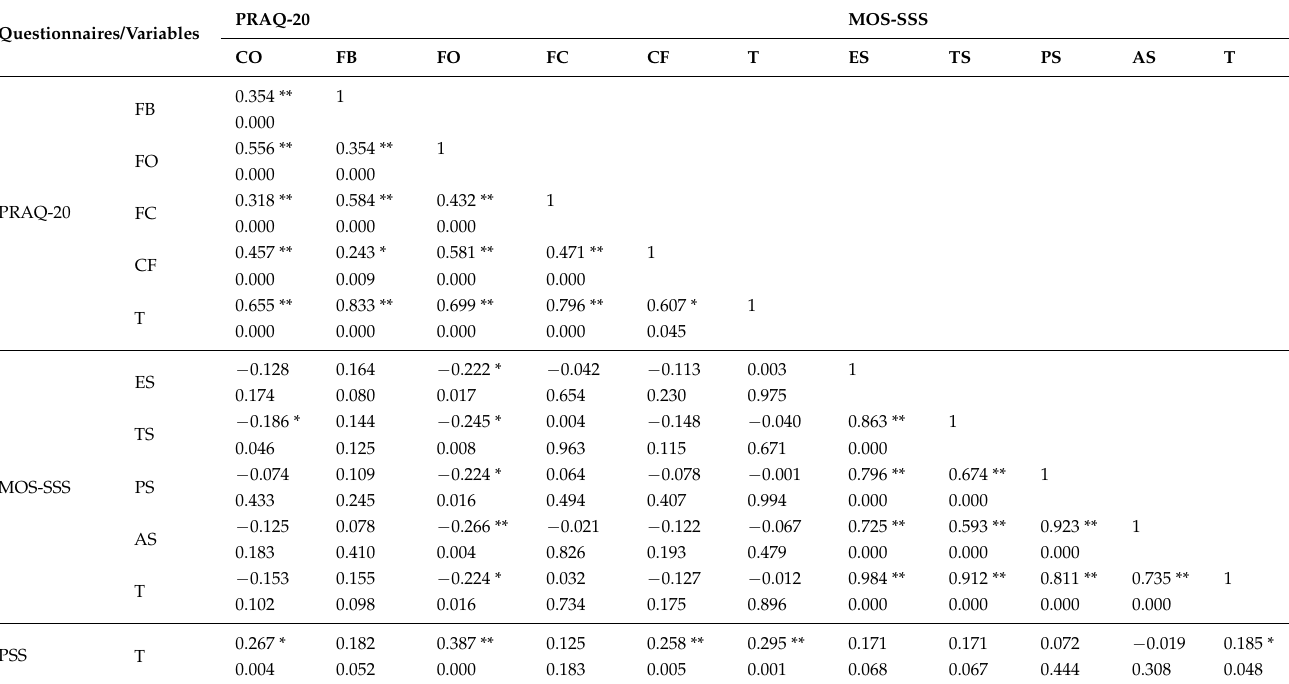
Table 3. Pearson inter-scale correlations between all variables included in the present